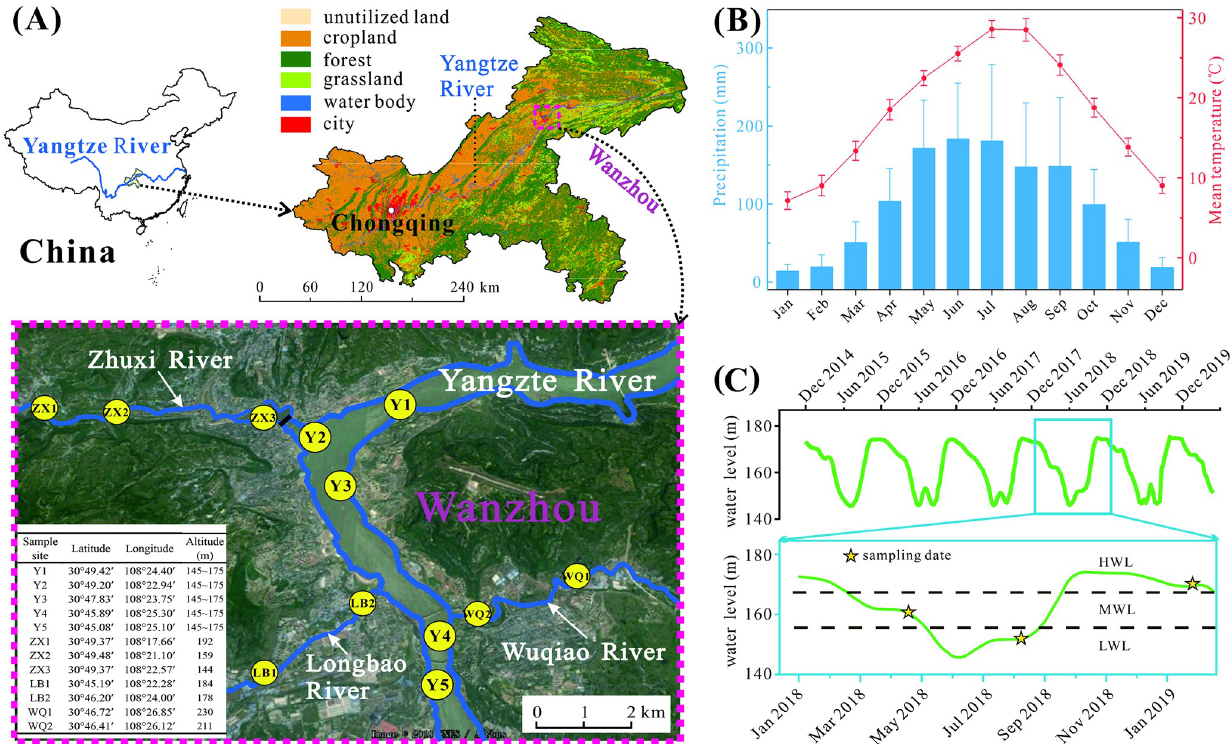
Fig 1. Sampling sites and the hydro-climatical information. (A) Sampling sites were located in Wanzhou City of Chongqing, as well as the land utilization of Chongqing in 2018 for background reference; (B) The monthly mean temperature and precipitation of Wanzhou City; (C) The water level fluctuations in recent five years with zoom-in details from January 2018 to January